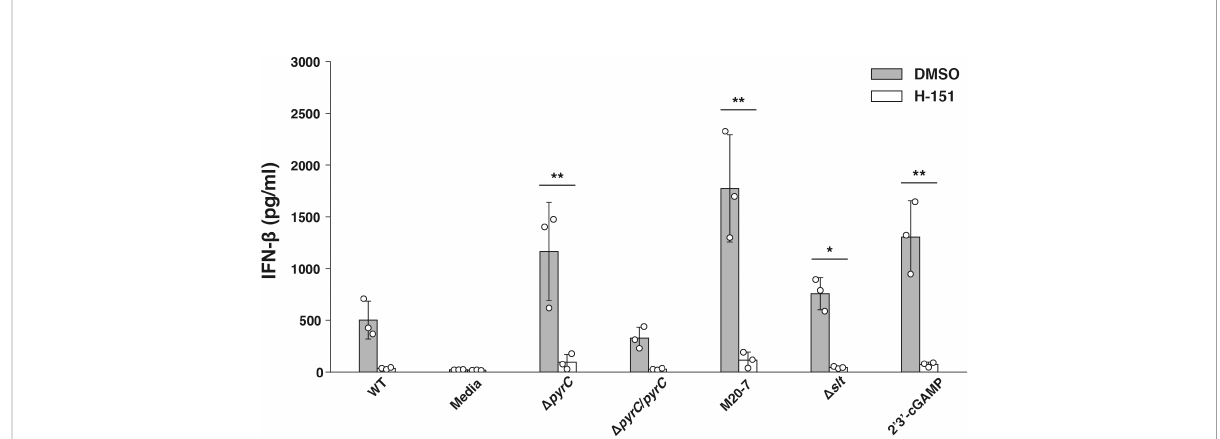
FIGURE 5 IFN- b induction by the F. novicida pyrC deletion mutant under STING inhibition. U937 cells were treated the H-151 STING inhibitor 2 h prior to infection and then stimulated with 10 ng/ml 2 ′ 3 ′ -cGAMP, BHIc medium or infected with F. novicida strains (MOI = 1). At 24 h post infection, cell supernatants were collected, and concentrations of IFN- b were measured by ELISA. Data shows averages and standard deviations from three independent experiments. The differences among various conditions were determined by Tukey – Kramer multiple comparison and are indicated by asterisks ** P < 0.01, * P <